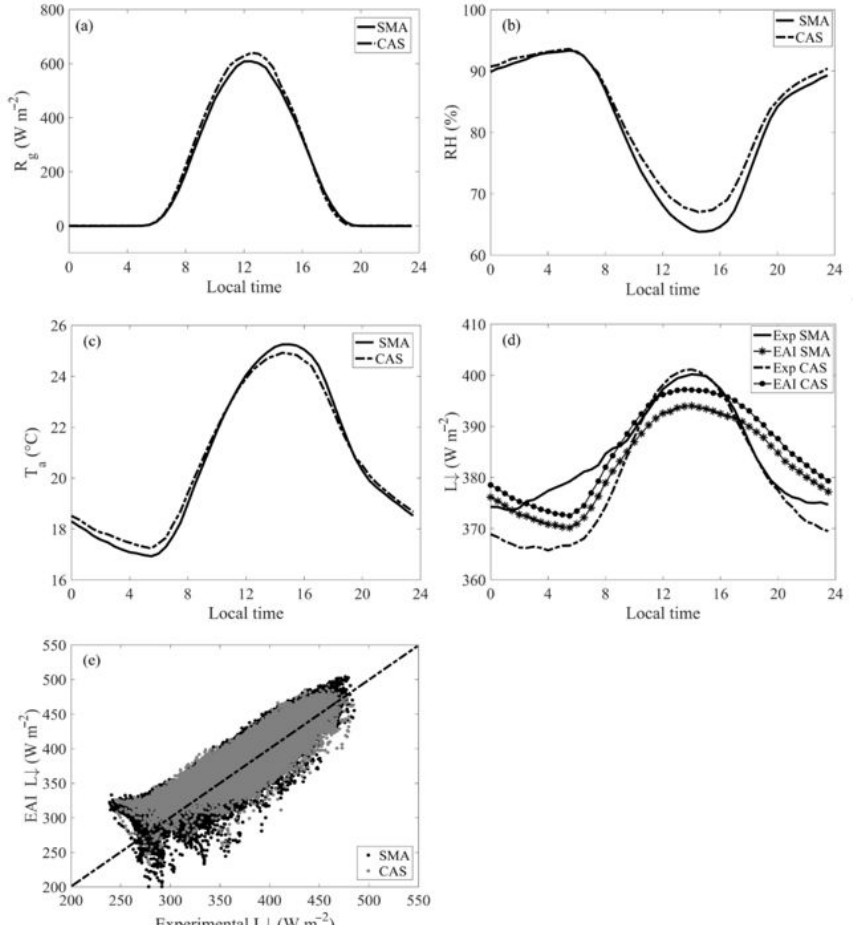
Figure 3. Diurnal cycle of atmospheric variables and experimental and estimated EAI L ↓ for SMA and CAS from 01 January 2014 to 16 April 2016: ( a ) global solar radiation ( R g ); ( b ) relative humidity ( RH ); ( c ) and air temperature ( T a ); ( d ) downward longwave radiation ( L ↓ ) and ( e ) scatter plot of half-hour experimental and estimated L ↓ . The 1:1 line (dotted black line) are presented. The statistics indices of panel ( e ) are shown in Table 7 (SMA: R 2 = 0.69; RMSE = 22.84 Wm − 2 ; CAS: R 2 = 0.67; RMSE = 25.33 Wm − 2